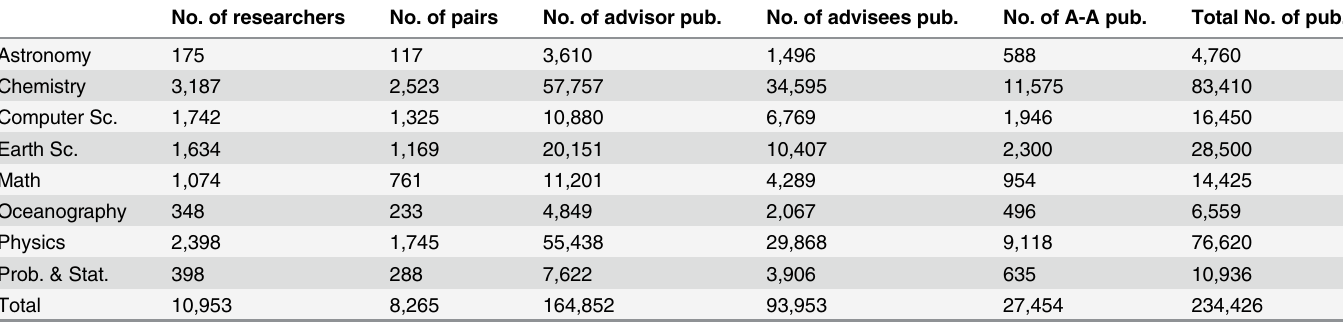
Table 1. Number of researchers, number of advisor-advisee pairs and number of publications for each subarea. No. of researchers No. of